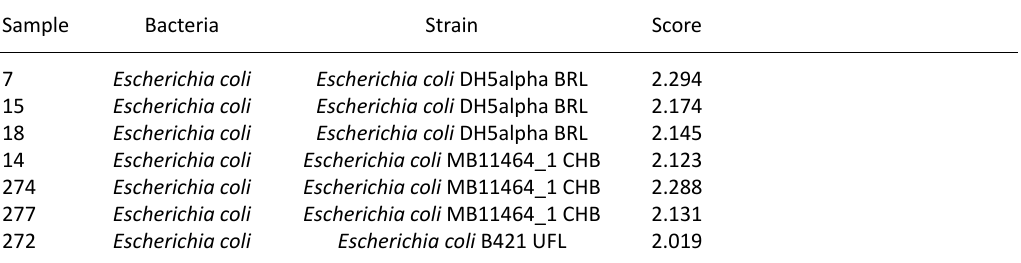
Table 1. Bacterial strains identified by Bruker Daltonik Biotyper